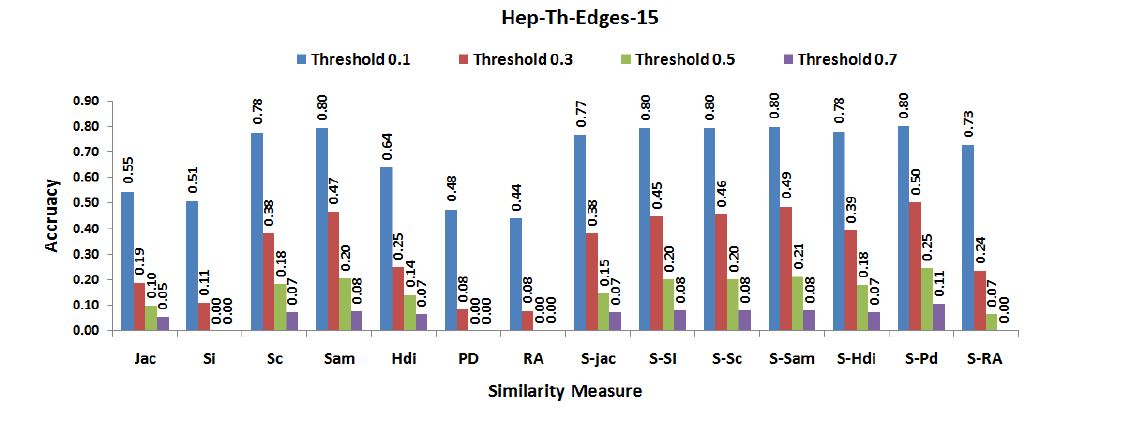
Figure 12. Prediction Results using HepTh Dataset with 10% Edges